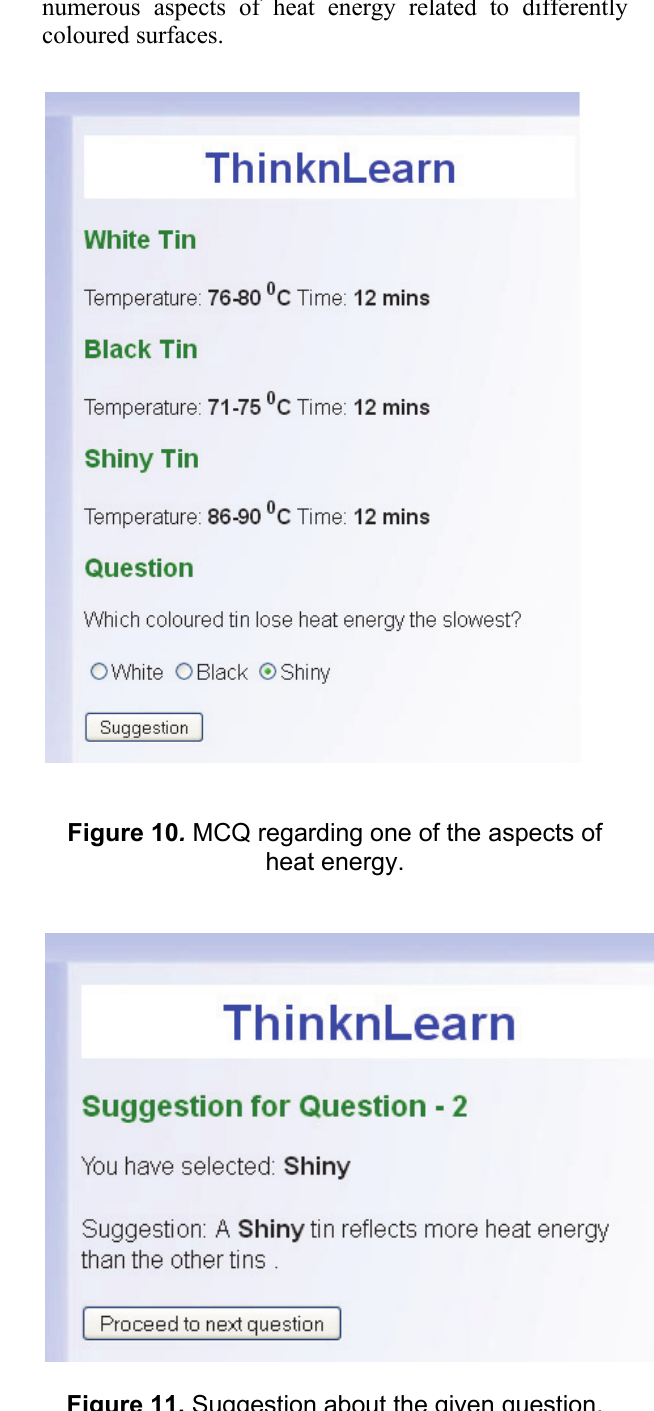
Figure 11 . Suggestion about the given